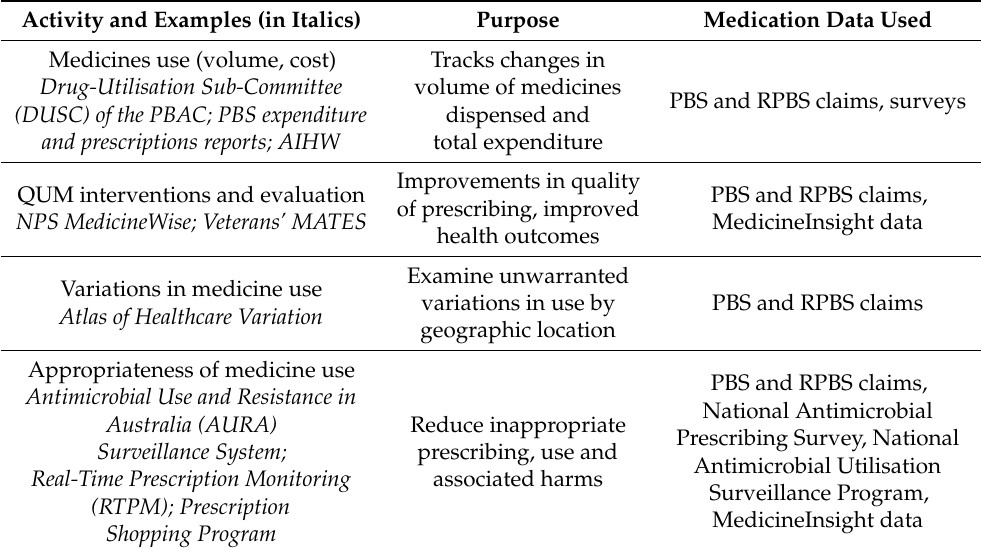
Table 2. Government monitoring and evaluation